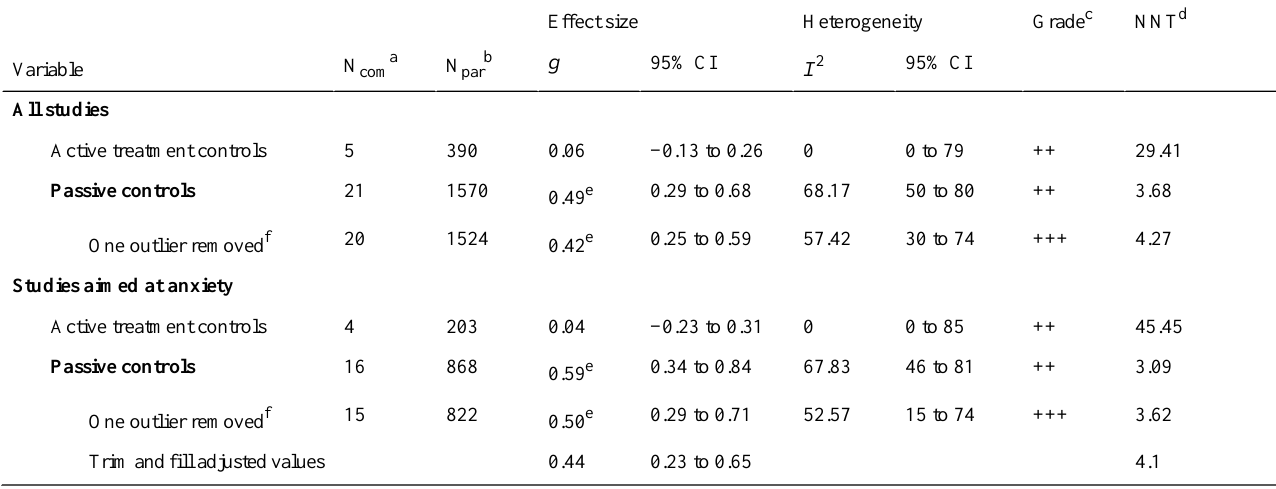
Table 4. Effect sizes regarding anxiety symptoms in the meta-analysis of studies comparing computerized cognitive behavior therapy in adolescents and young adults with active treatment and passive controls at